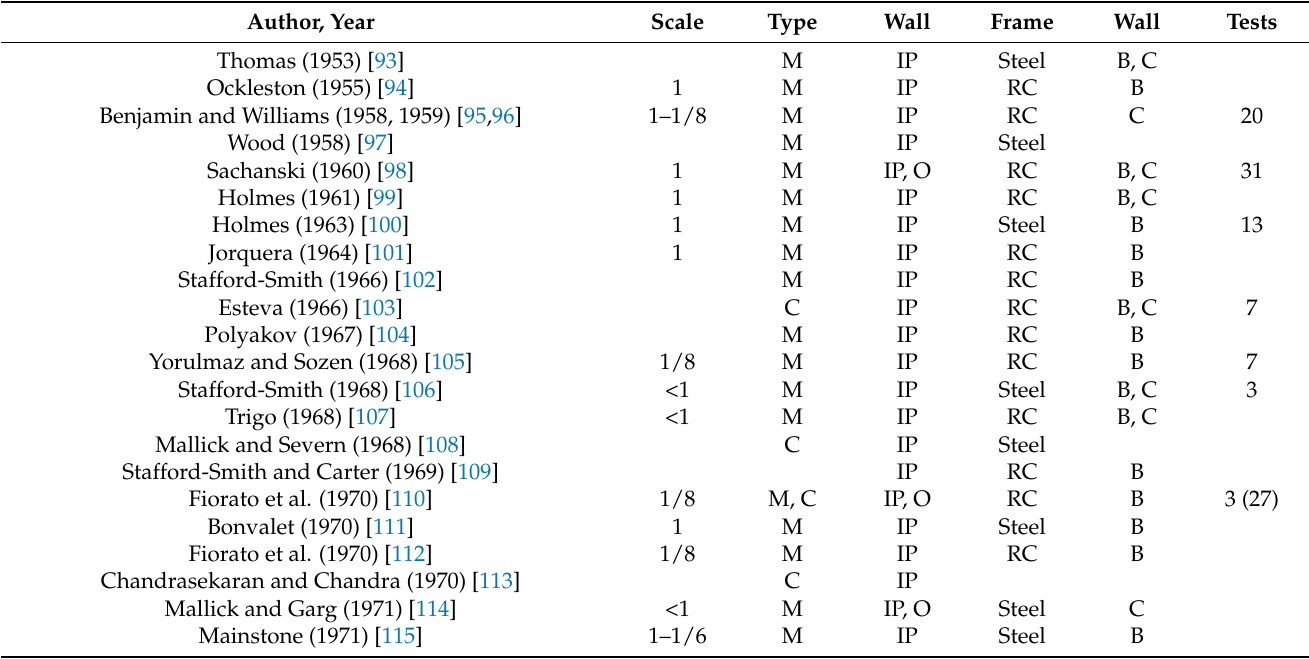
Table 5. Experimental work for infilled